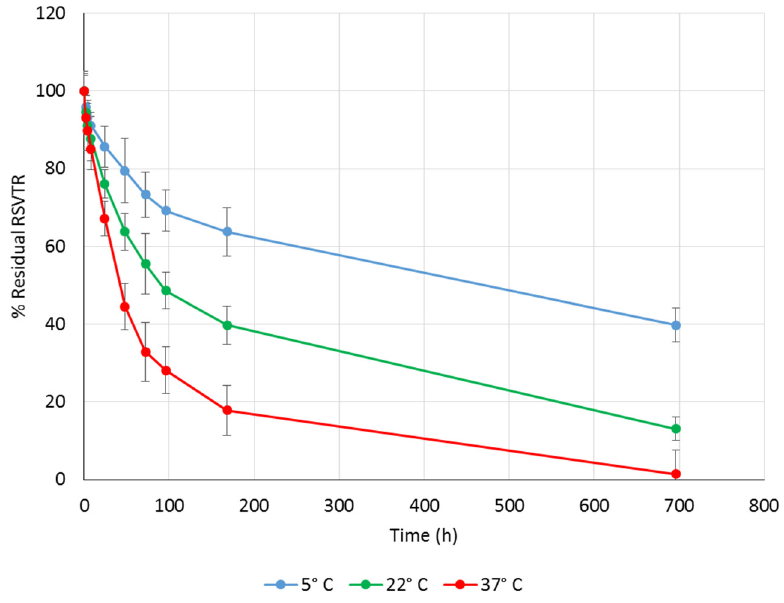
Figure 3. Percentage of residual RSVTR vs. time after incubation at pH 7.2 and different tempera- tures.